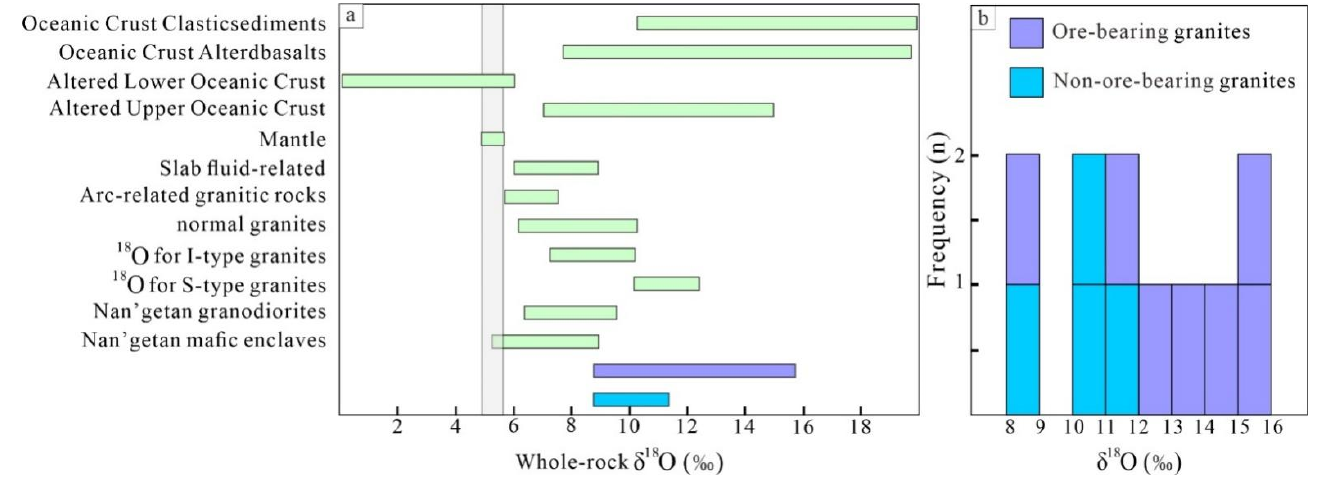
Figure 8. O isotope comparisons of known rock types ( a ), and isotopic compositions of Asiha complex ( b ). Data sources: fresh MORB [57], altered upper and lower oceanic crusts [58], arc-related granitic rocks [59], slab fluid-related and arc fractionation trend [55], normal granites, 18 O for I-type granites and 18 O for S-type granites are taken from [60], Nan’gentan granites and MME after [29].